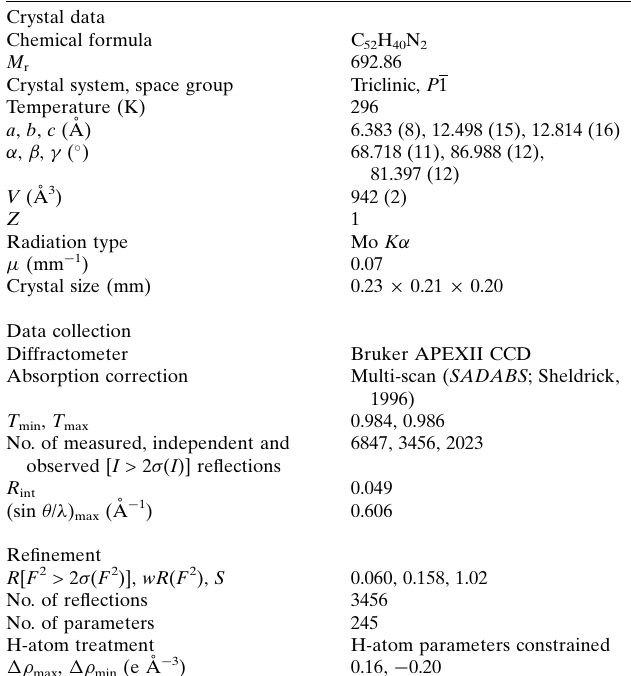
Table 2 Experimental details.